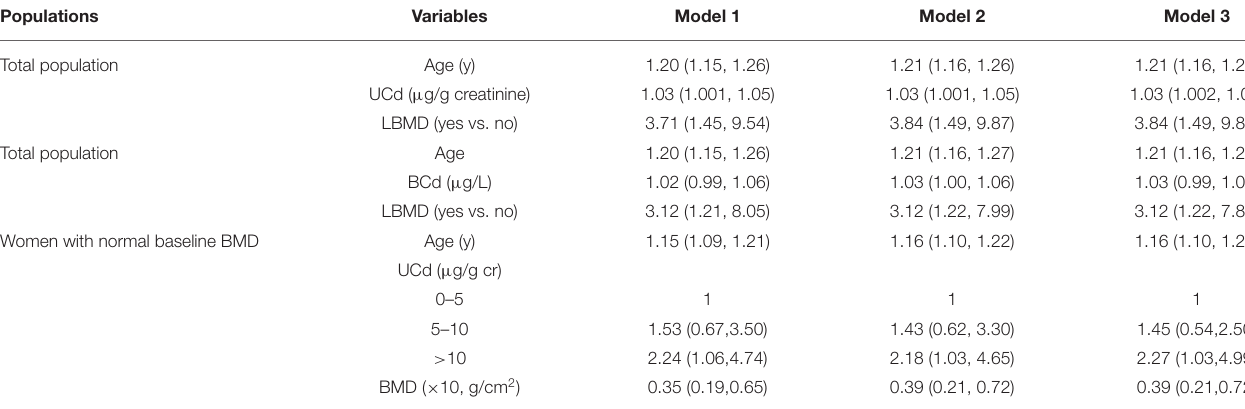
TABLE 3 | Adjusted ORs (95% CI) of incident of osteoporosis in total population and women with normal baseline BMD.